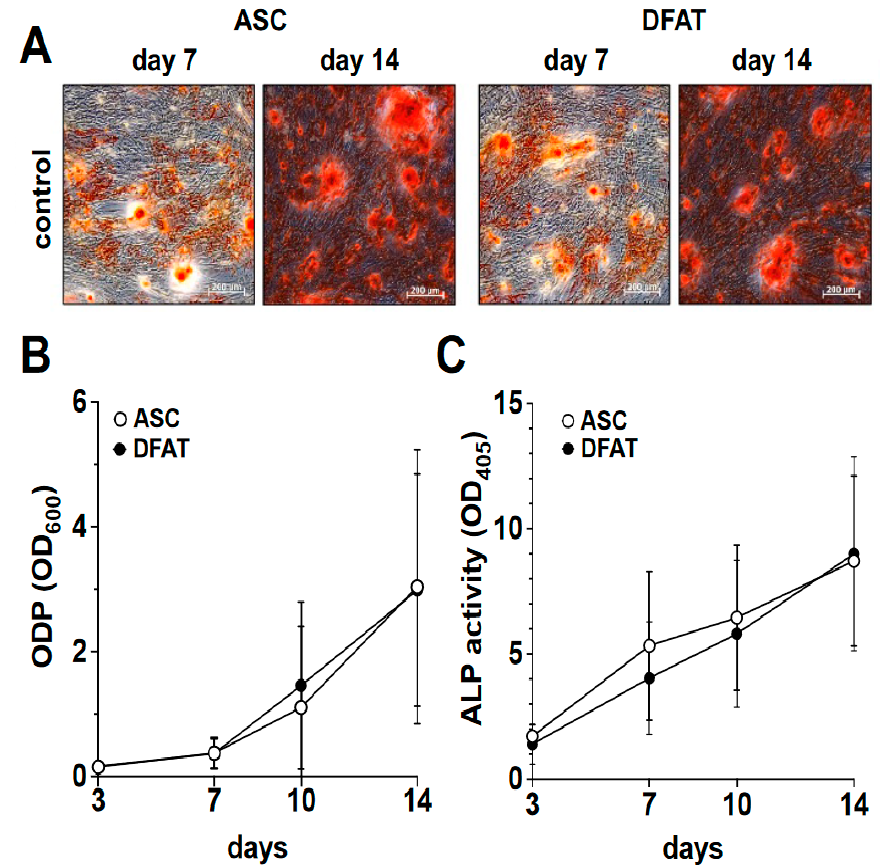
Figure 2. Osteogenic differentiation potential of ASC and DFAT cultures obtained from the same adipose tissue sample. ( A ) Alizarin Red stain of osteogenically activated ASC and DFAT cultures at day 7 and day 14 of differentiation, scale bars 200 µ M. ( B ) Quantitative evaluation of the osteogenic differentiation potential (ODP) of osteogenically activated ASC (white circles) and DFAT (black circles) cultures. The values show the mean ± standard deviation of values ( n = 9) of the optical density of the Alizarin Red redissolution at 600 nm (OD 600 ) of the cultures and days of differentiation indicated. ( C ) Quantitative evaluation of alkaline phosphatase (ALP) activity of osteogenically activated ASC (white circles) and DFAT (black circles) cultures. The values show the mean ± standard deviation of values ( n = 9) of the optical density of the ALP-assay-specific alkaline phosphatase product 405 nm (OD 405 ) of the cultures and days of differentiation indicated.